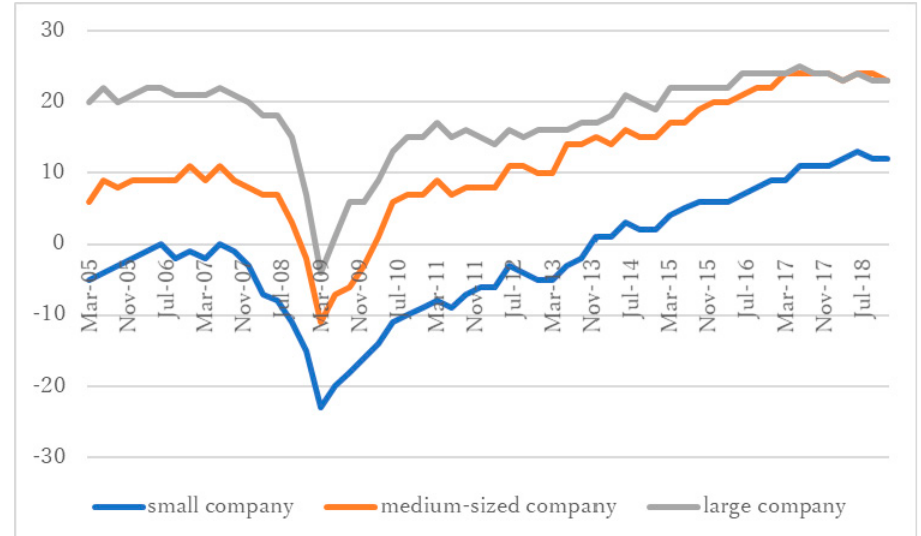
Figure 2. Funding conditions di ff usion index (All industries). Funding conditions di ff usion index is defined as the di ff erence between the ratios of those who choose funding conditions as good and those who choose funding conditions as bad. Source: Bank of Japan’s Tankan survey (Quarterly survey of business